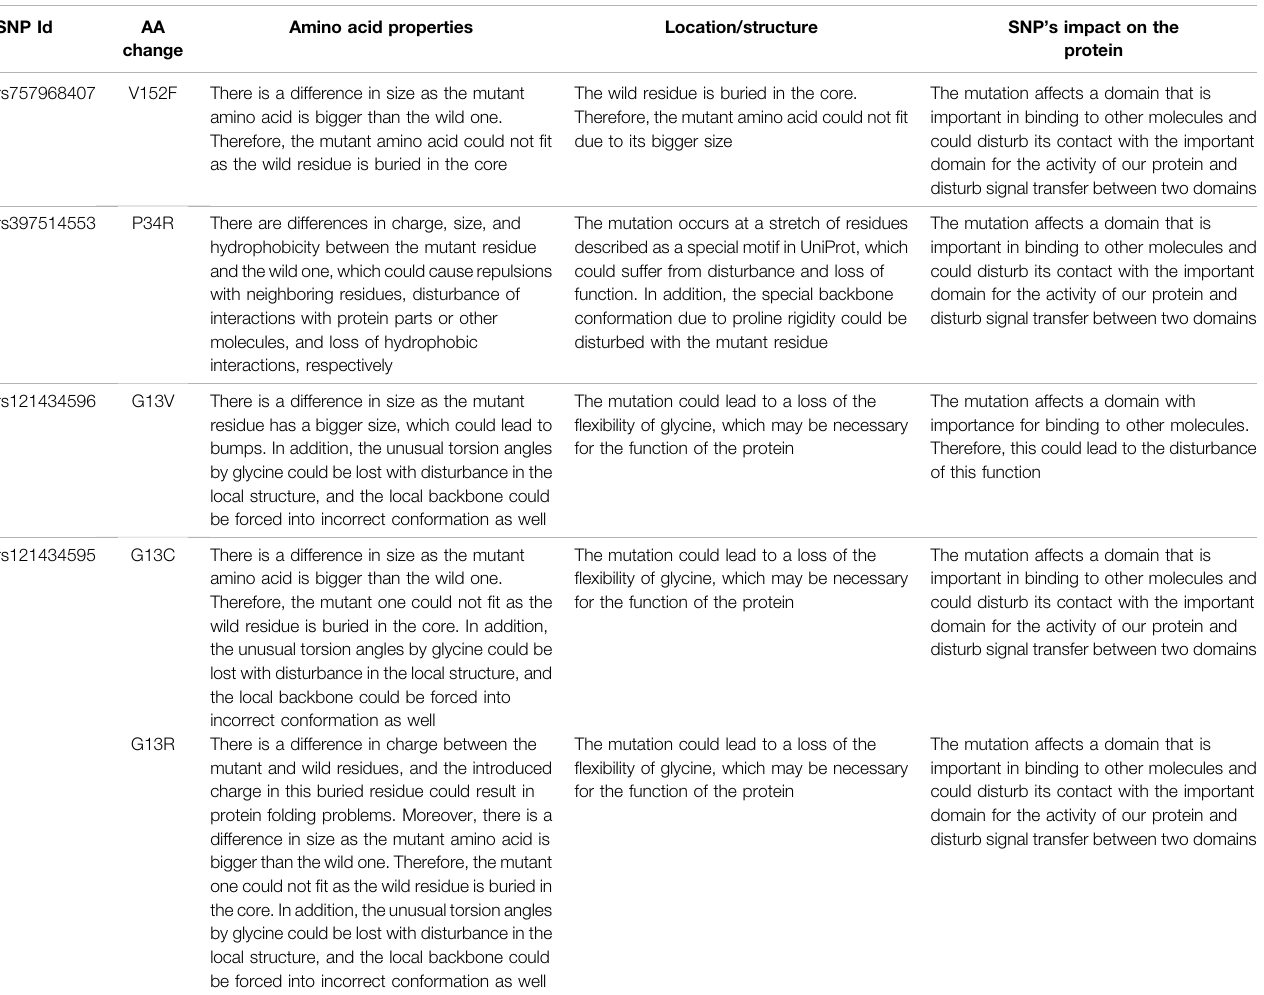
TABLE 7 | Predicted SNP impacts on NRAS protein structure by HOPE